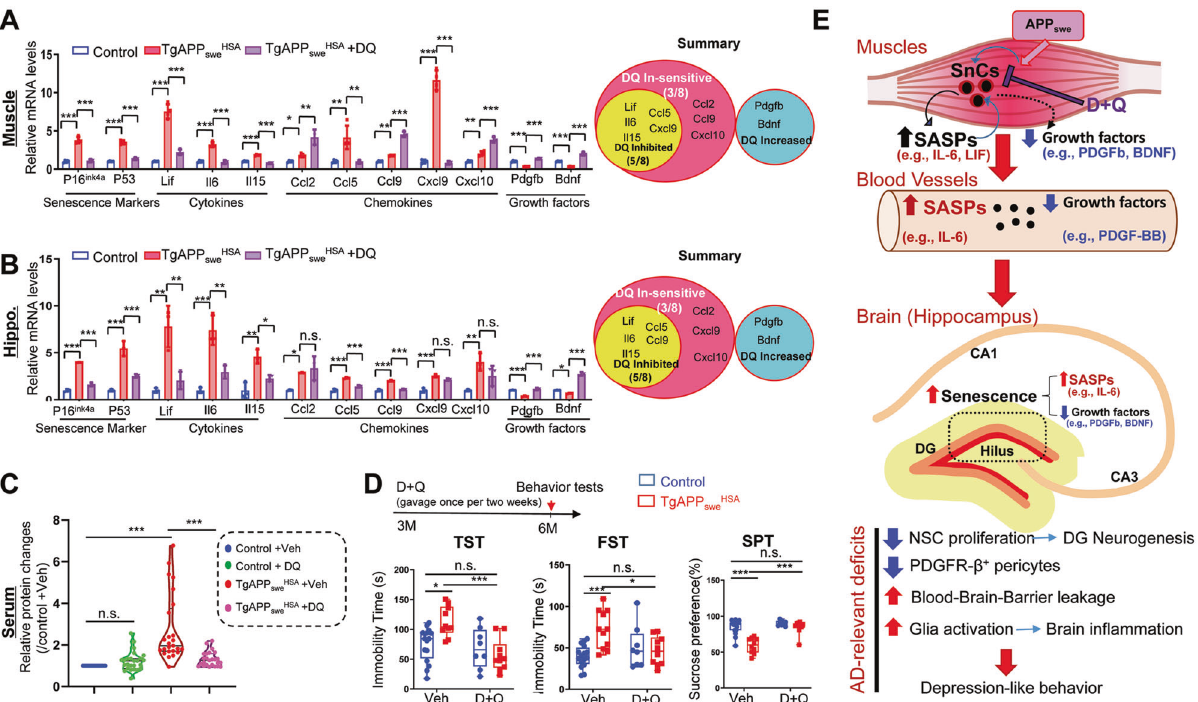
Fig. 7 Attenuated depression-like behavior de fi cit in TgAPP sweHSA mice treated with senescence inhibitors. A , B RT-PCR analysis of indicated gene expression in the TA muscles ( A ) and hippocampus ( B ) of 6-MO control and TgAPP sweHSA mice with Veh or DQ treatments, data are present as mean ± SD, * p < 0.05, ** p < 0.01, *** p < 0.001, n = 4 mice/group, one-way ANOVA followed by Sidak ’ s multiple comparisons post hoc test was used. C Summaries of DQ drugs ’ effect on the factors tested in serum in Fig. S14. each dot represents different factors, and relative fold change over control mice treated with vehicle was shown, two-way ANOVA followed by Sidak ’ s multiple comparisons post hoc test was used. D A schematic diagram of the experimental design and the quanti fi cations of depression-like behaviors using TST, FST, and SPT. 6-MO control ( LSL-APP swe , , males) and TgAPP sweHSA mice were treated with Veh (10%PEG 400) or DQ (D 5 mg/kg, Q 50 mg/kg, dissolved in 10% PEG 400, once per two weeks), starting at age of 3-MO, and then subjected to indicated behavior tests at 6-MO. All data are presented as